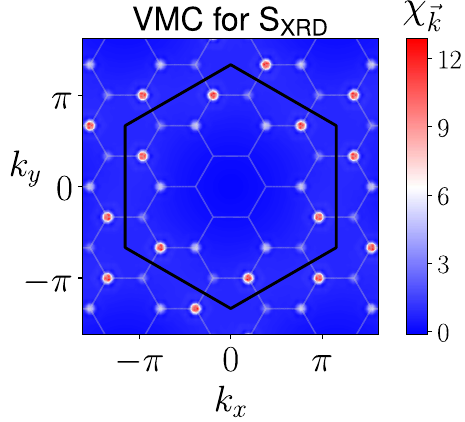
Fig. 7 Variational Monte Carlo result. Spin susceptibility in momentum space [Eq. (7)] computed by VMC. The results refer to the optimal variational state for the Hamiltonian of Eq. (1) with the exchange couplings of the S XRD structure of Y-kapellasite (see Supplementary Table 1). The calculation is performed on a fi nite cluster of N = 972 sites (type-II, L = 6, cf. Supplementary Note